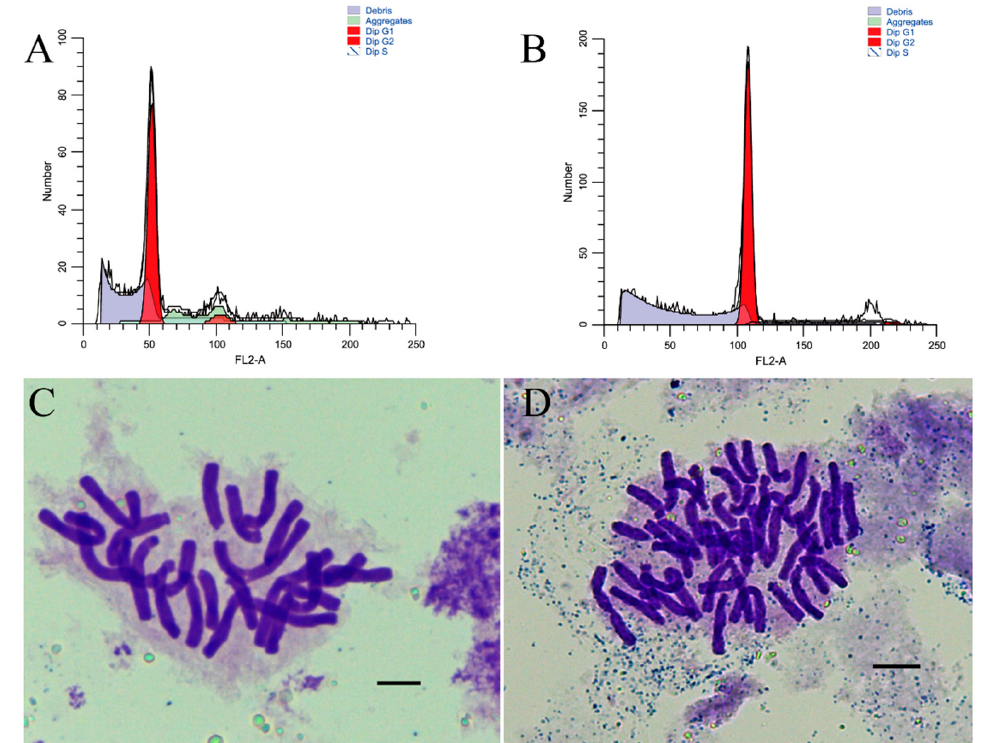
Figure 1. Ploidy confirmation of polyploidization − induced lily plantlets. ( A , B ) Flow cytometry histograms of the allodiploids ( A ) and allotetraploids ( B ). ( C , D ) Chromosomes in root tip cells from allodiploid (2n = 2x =24) ( C ) and allotetraploid (2n = 4x = 48) ( D ) plants; bars = 10 μ m.